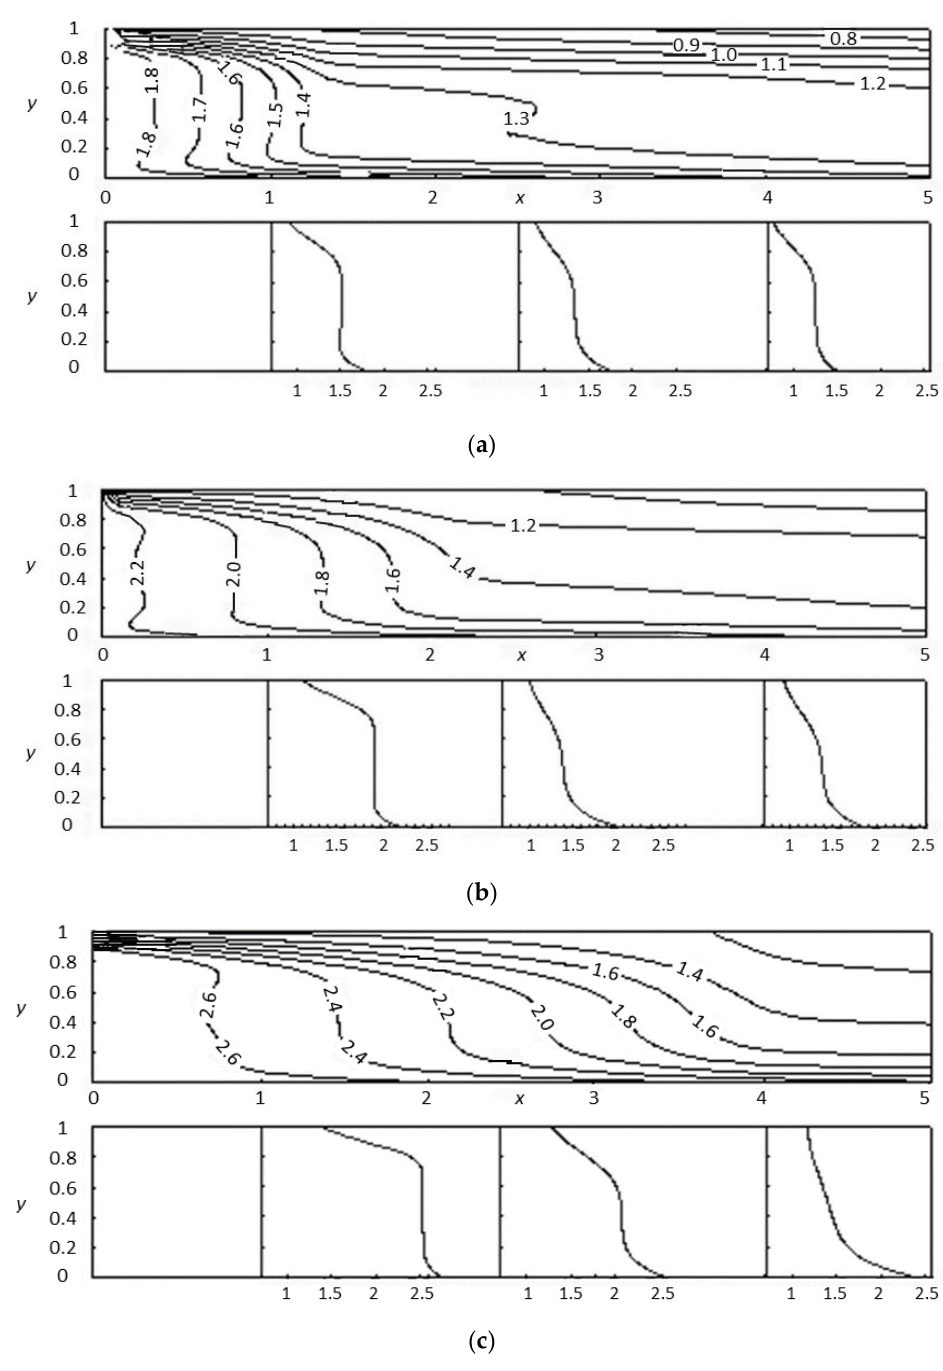
Figure 7. Contours of fluid density taken at different dimensionless times: ( a ) 0.57; ( b ) 1.0; ( c ) 2.0.